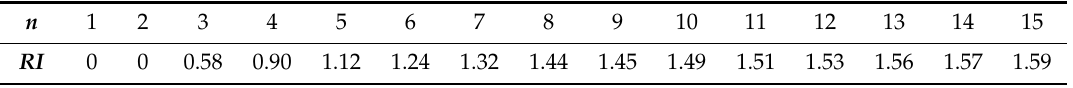
Table 2. The random consistency index value depending on the size of the